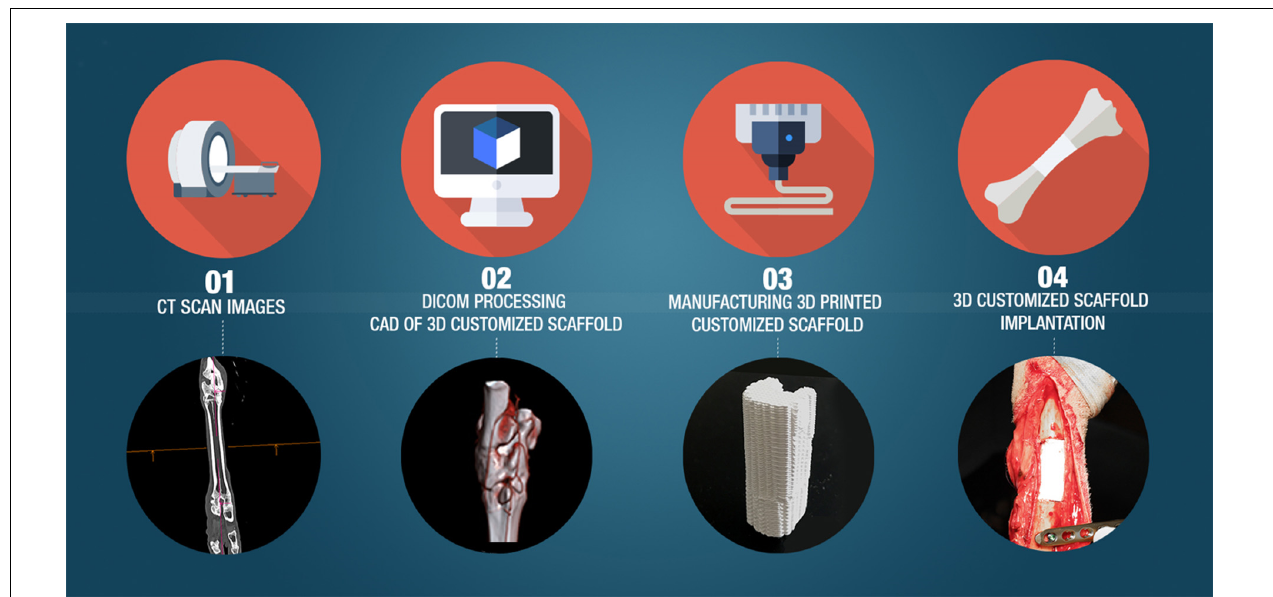
FIGURE 3 | Workflow involved in customizable bone construct fabrication. (1) CT scans of the patient’s bone are acquired. (2) Computer aided software enables the processing of CT images in order to (3) 3D print personalized scaffolds for (4) bone defect reconstruction. The lower panel illustrates a real large bone defect reconstruction in a sheep metatarsal bone